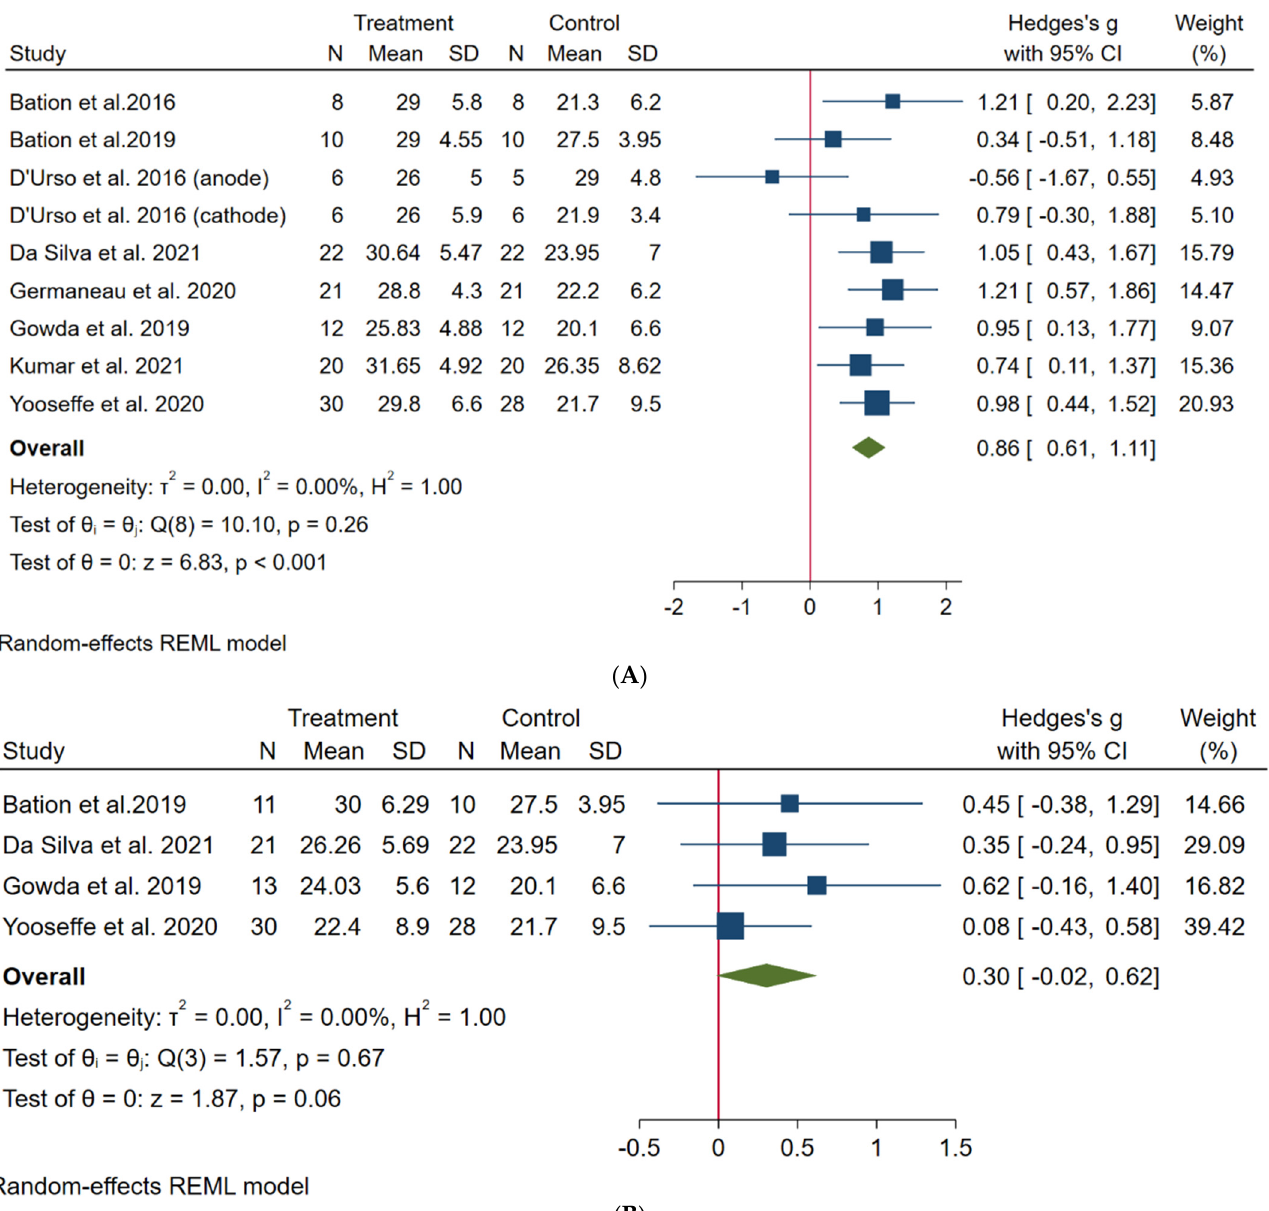
Table 2. Results of univariate meta-regression analyses.